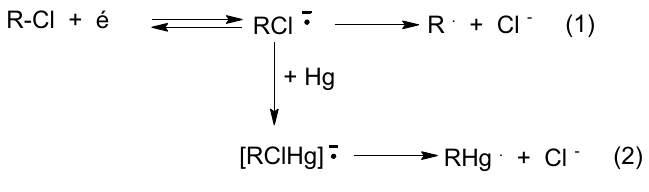
Fig. 6 – Reduction scheme of clotrimazole on mercury electrode.